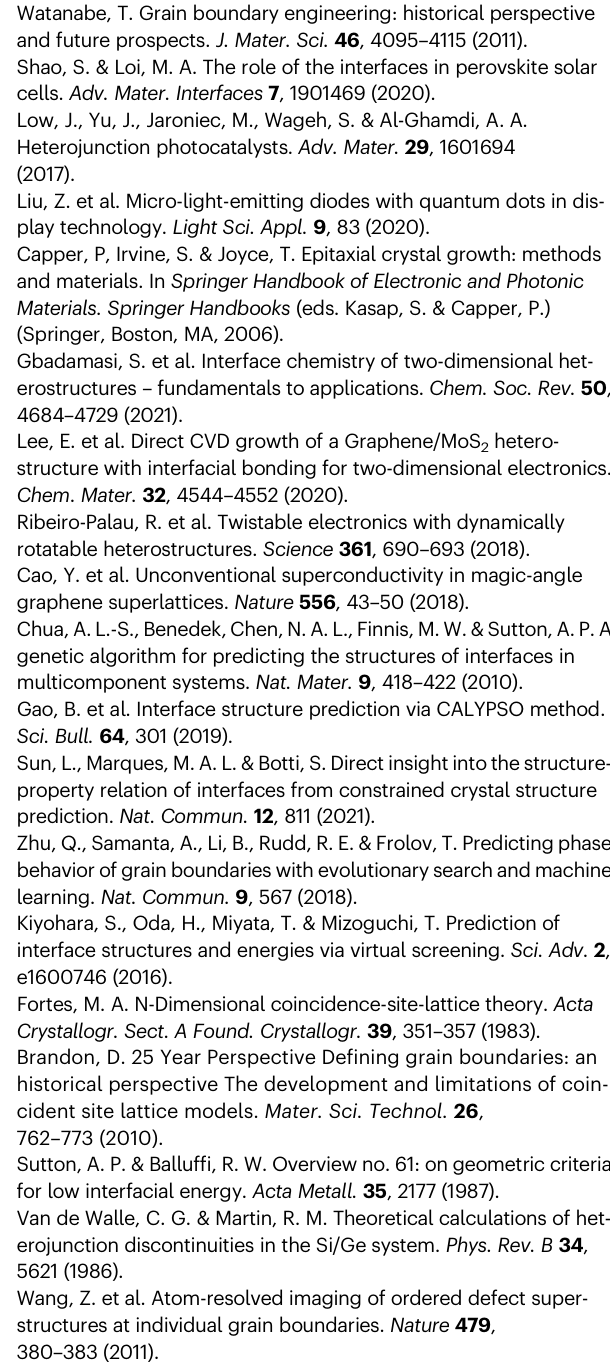
Relative interface energetic stabilities for our disk inter-